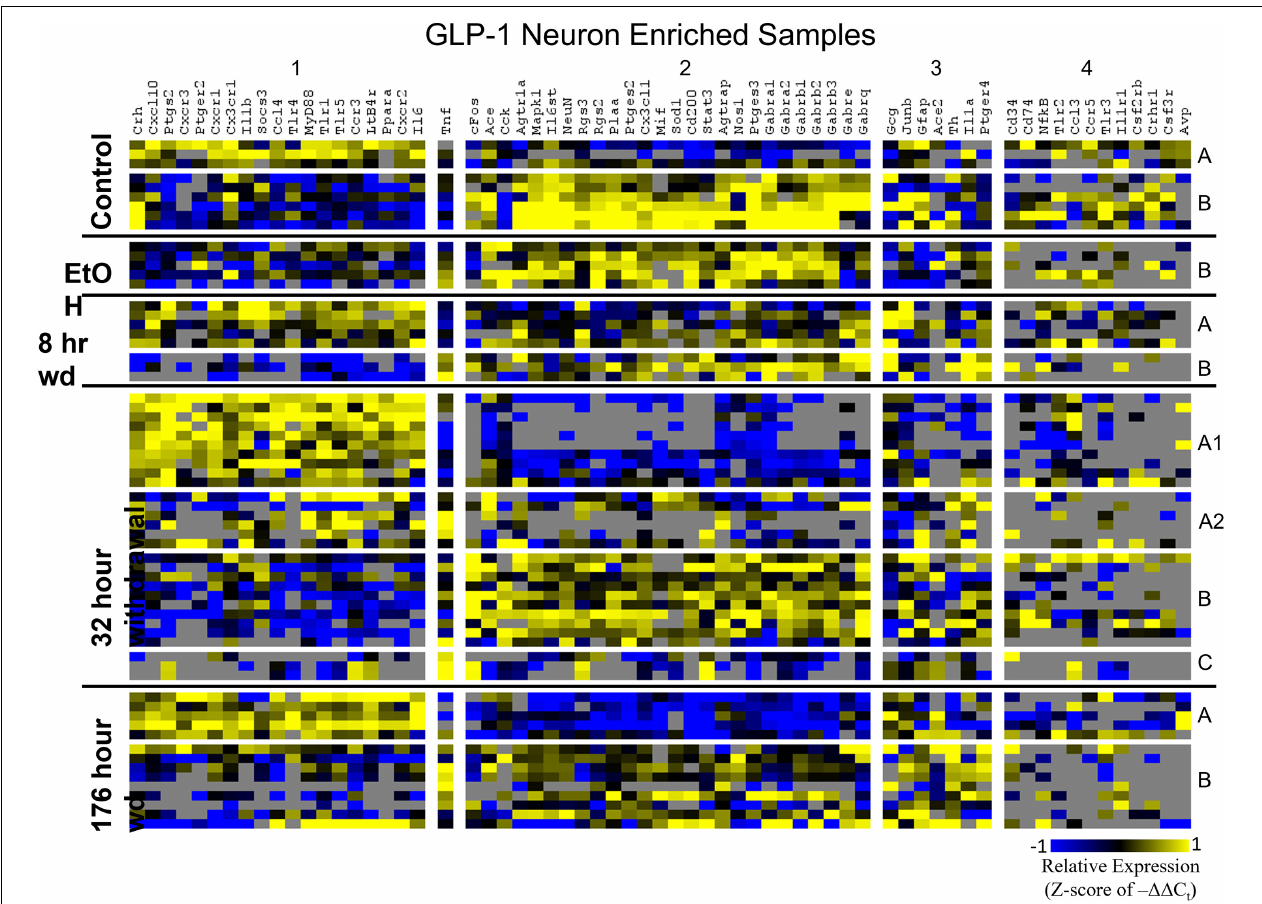
FIGURE 4 | Heat Map of GLP-1 Neurons. Heat map displays cellular subphenotypes within GLP-1 neuron enriched samples through alcohol withdrawal time series. Rows represent 10-cell pooled samples with cellular subphenotype clusters labeled with uppercase letters. Columns represent the z-score of – (cid:49)(cid:49) C t gene expression values on a –1 to 1 color scale for that gene in that sample. Gene clusters are labeled by